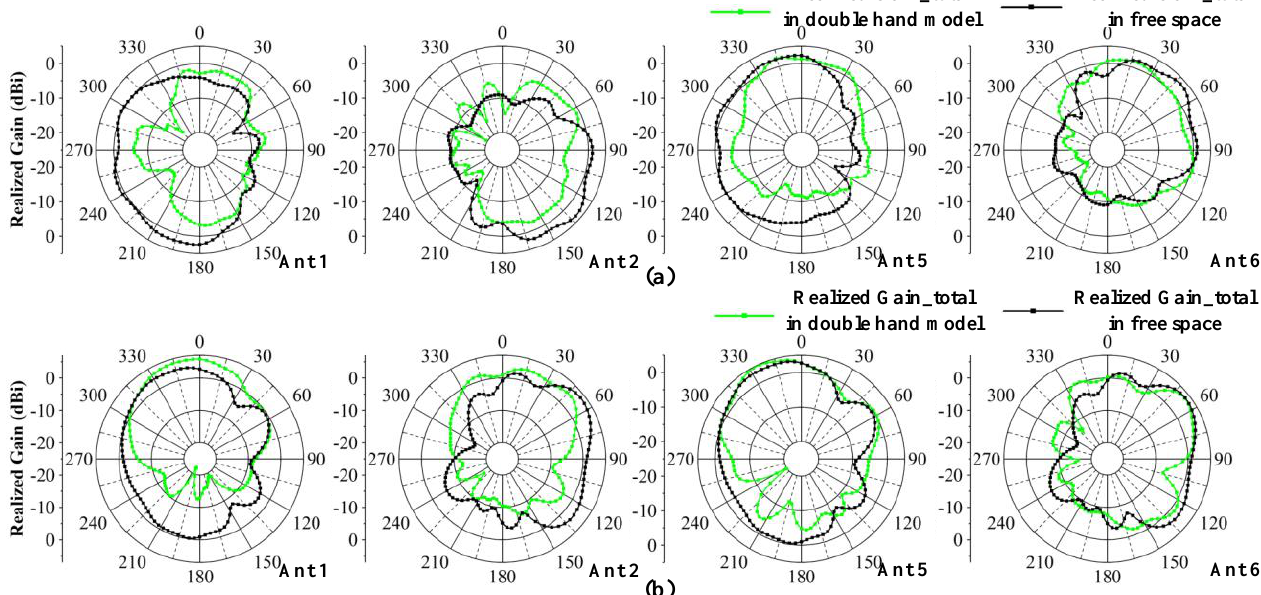
Figure 24. Comparisons of the radiation pattern observed from 4.5 GHz. ( a ) 2-D radiation pattern in the 𝑥𝑜𝑦 plane. ( b ) 2-D radiation pattern in in the 𝑦𝑜𝑧 plane.